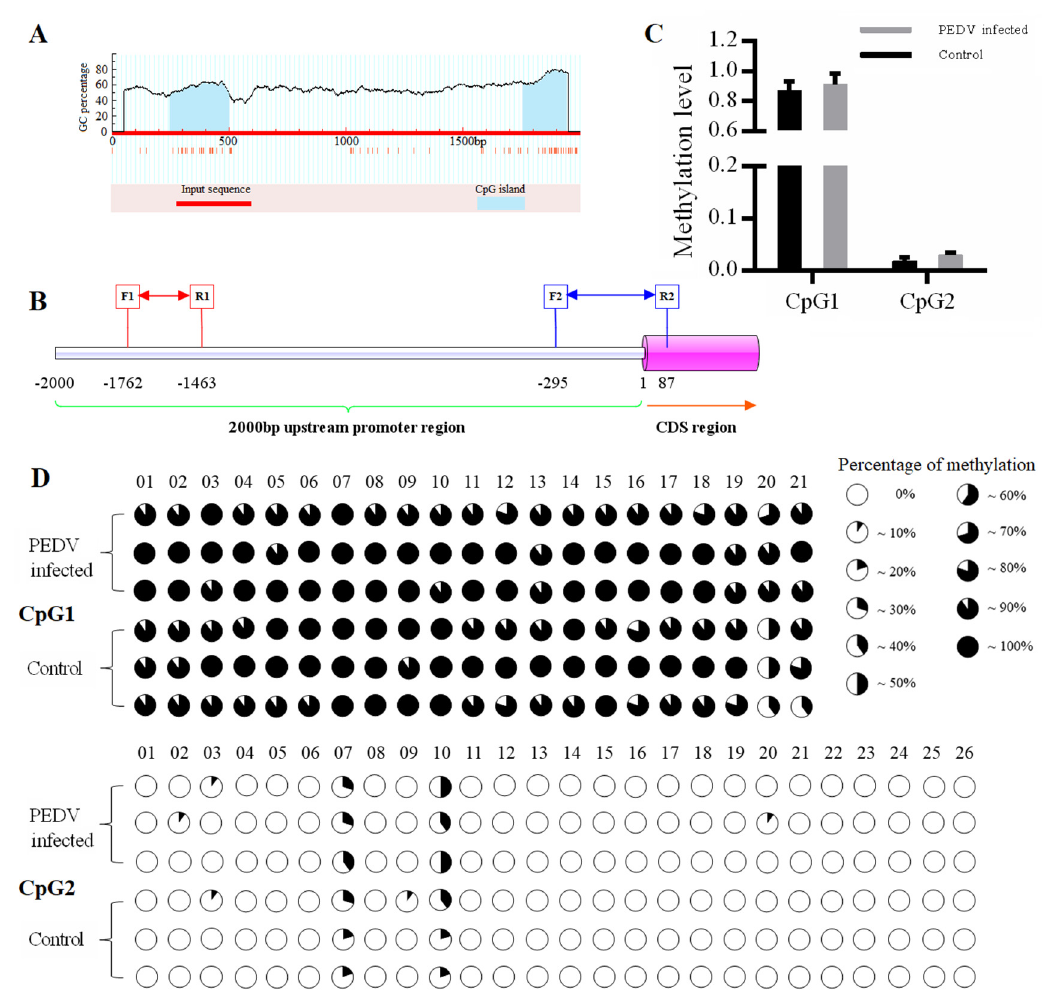
Figure 3. Prediction of CpG islands and methylation status of CpG sites in the promoter region of the porcine AQP3 gene. ( A ): CpG island prediction in the upstream 2000 bp promoter region of the porcine AQP3 gene; ( B ): Sequence location of the target fragment of the two pairs of methylation sequence primers; ( C ): Methylation level of CpG islands; CpG1 and CpG2 are the first and second CpG islands, respectively; ( D ): Analysis of the methylation status of CpG sites in two CpG islands in the porcine AQP3 gene promoter region; the top two groups represent CpG1 and the bottom two groups represent CpG2. CpG sites are marked with pie charts in which the black region represents the methylation level.